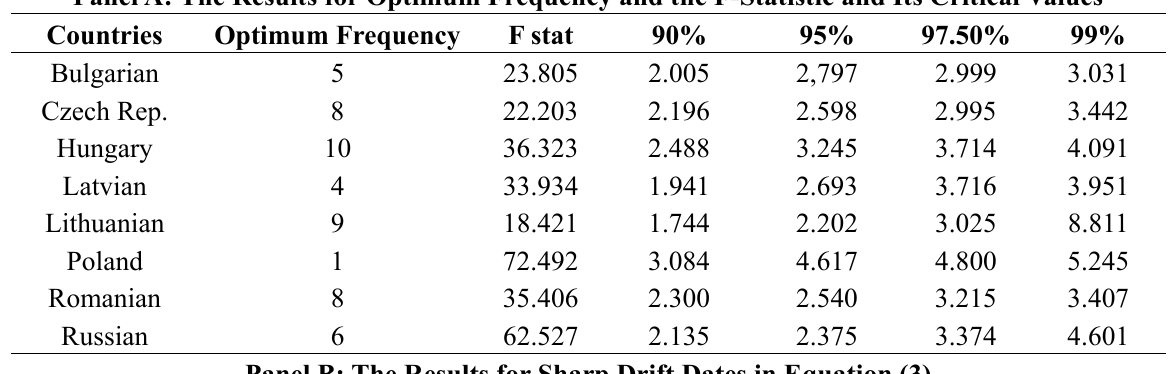
Panel B: The Results for Sharp Drift Dates in Equation